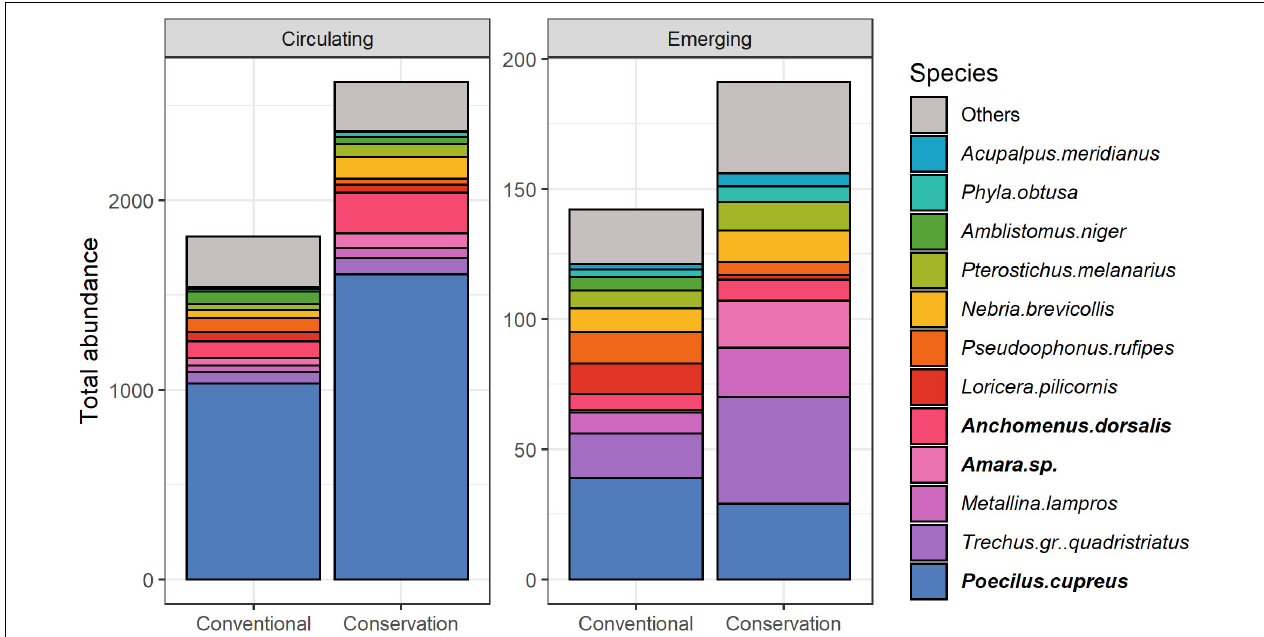
FIGURE 2 | Variations of cumulative abundance of carabid species representing at least 75% of the total abundance depending on soil management and type of community. Indicator species are bolded. Take note that the scales are different between circulating and emerging carabid communities.